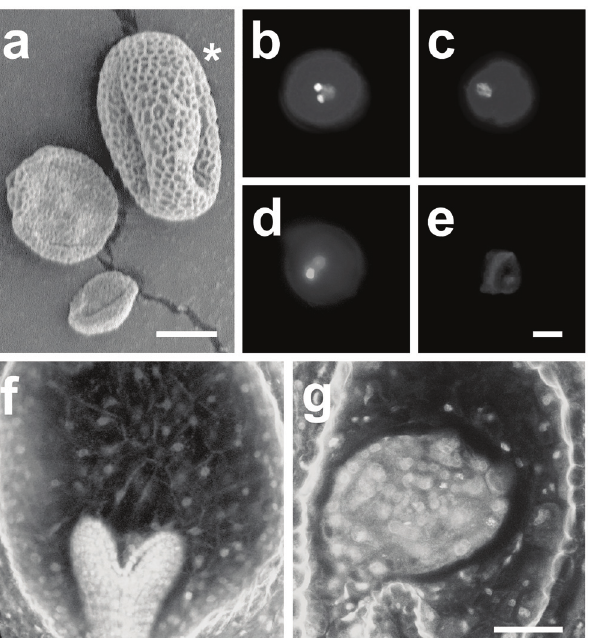
Fig 5. Effect of the rsw7-lph mutation on cellularization of the male gametophyte and endosperm. ( a ): Pollen produced by rsw7-lph /+ plants; scanning electron micrograph showing a mixture of normal (star) and shriveled or collapsed grains; scale bar equals 10 μ m. ( b – e ): Cell division defects of rsw-lph male gametophytes. DAPI staining of normal pollen ( b ) reveals two small, brightly staining sperm cell nuclei and the large, less brightly staining nucleus of the vegetative cell; pollen of rsw7-lph /+ plants is frequently mono- nucleate ( c ), bi-nucleate ( d ), or collapsed with no detectable DNA ( e ); scale bar in ( e ) equals 10 μ m. ( f, g ): Absence of a cellularized endosperm in rsw-lph seed. Confocal micrographs of Schiff-stained seed show the presence of cell walls in the endosperm of seed containing wild type embryos ( f ) but not in seed containing mutant embryos ( g ); scale bar in ( g ) equals 50 μ